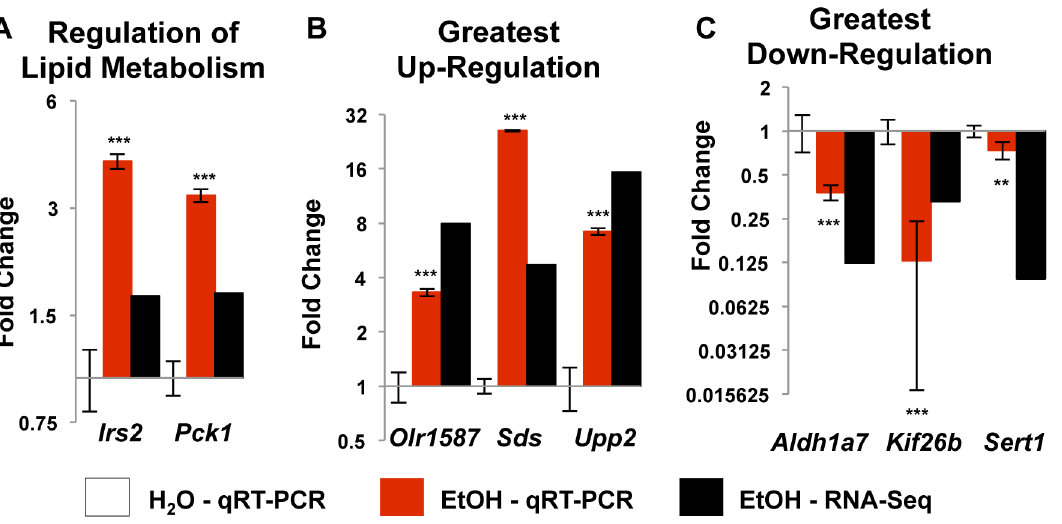
Fig. 4. Altered expression by qRT-PCR. ( A ) Irs2 and Pck1 , involved in the regulation of lipid metabolism, were up-regulated by RNA-Seq analysis and confirmed by qRT-PCR. ( B ) and ( C ) confirm the genes with the greatest up-regulation and down-regulation, respectively. The direction of the change was confirmed for all 6 genes, though not necessarily to the same degree. ** - p-value , 0.005, *** - p-value ,